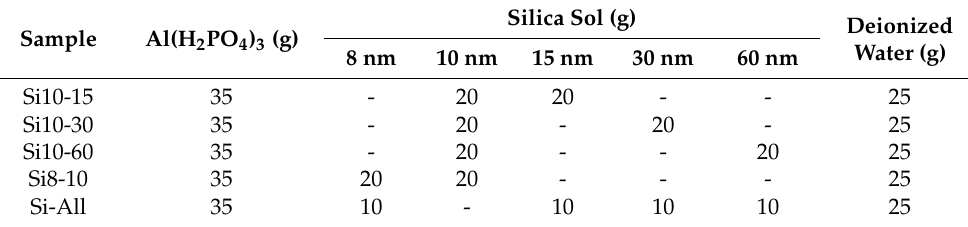
Table 2. Coatings with silica sols of different particle